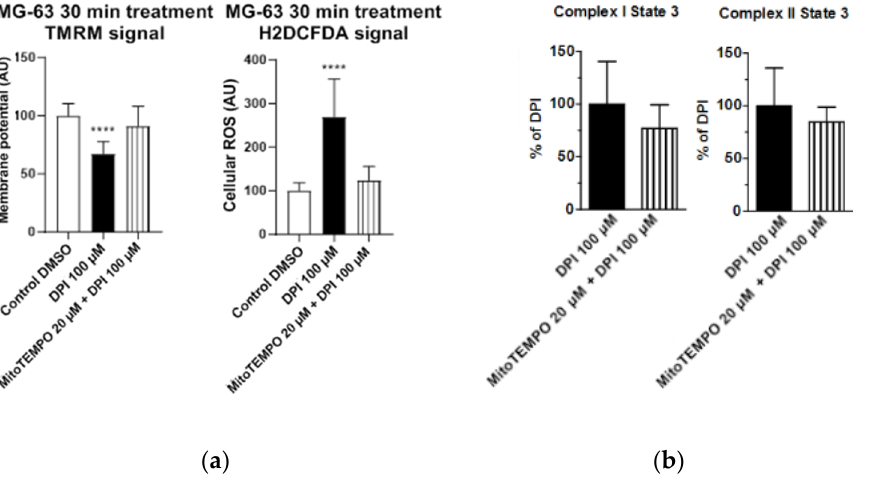
Figure 4. Effects of 20 µ M MitoTEMPO pretreatment on MG-63 cells exposed to 100 µ M DPI. ( a ) Mitochondrial membrane potential and cellular ROS levels estimated with laser scan microscopy (LSM). MitoTEMPO is capable of preventing a decrease of the mitochondrial membrane potential and excessive generation of ROS. The images were taken with a Zeiss LSM 510 microscope, 10x objective, 50 nM tetramethylrhodamine methyl ester (TMRM) and 10 µ MH2DCFDA probe concentration. Data is represented as means + SD (error bars) ( n = 24; each point was obtained by analyzing 2–4 single cells. **** p < 0.0001; one-way ANOVA followed by multiple comparison post-hoc Fisher’s LSD test. ( b ) Cellular respiration measurements of Complex I and Complex II State 3 MitoTEMPO does not cause recovery of mitochondrial respiration. Means + SD, n = 4.